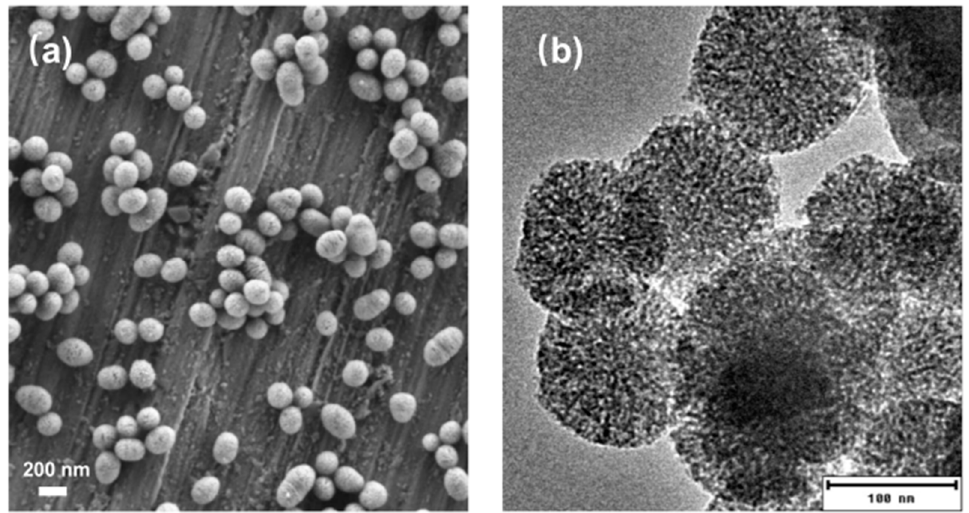
Figure 1. ( a ) SEM and ( b ) TEM images of Ce-MBGNs showing their spherical shape and mesoporous structure.